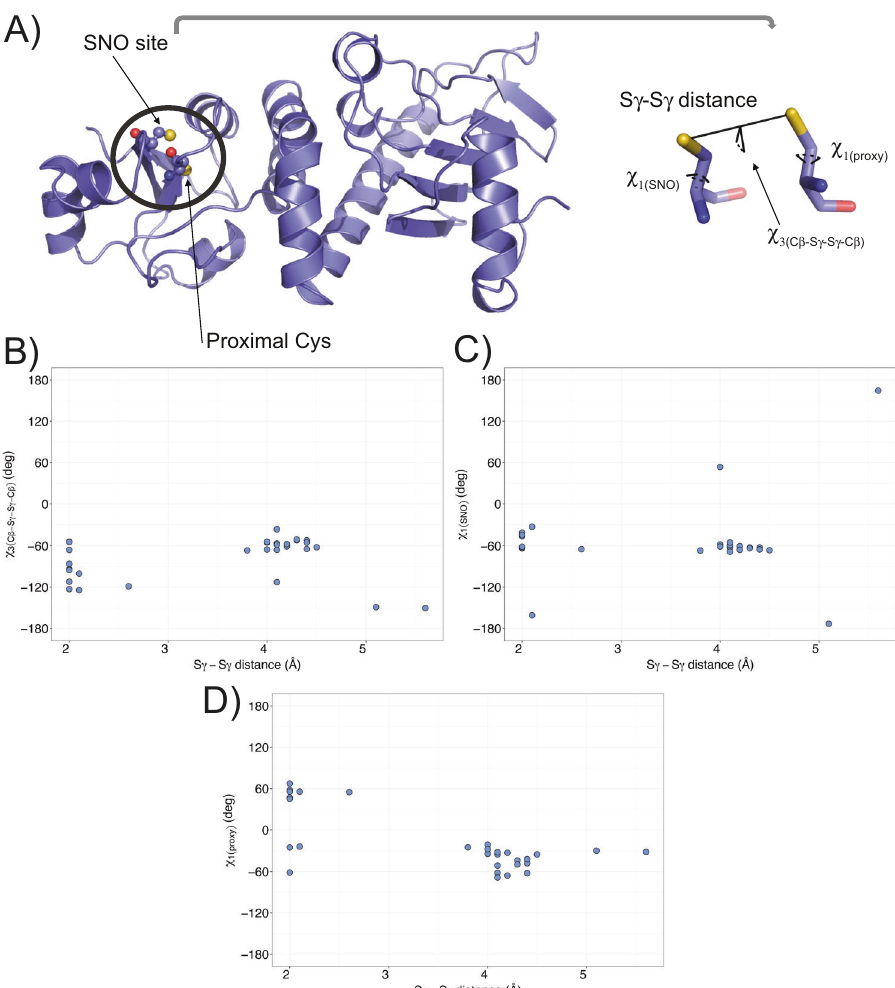
Fig. 1 Conformational heterogeneity of the S- nitrosylated cysteine and its proximal cysteine in the mitochondrial chaperone TRAP1. A In the left panel, the cartoon shows the X-ray structure of the middle domain of Danio rerio TRAP1 (PDB ID entry 4IPE, residues 311 – 567). The spheres indicate the atoms of the S- nitrosylated (SNO) site (C516) and the proximal cysteine (C542). In the right panel, the stick representation shows a conformation of the SNO site and the proximal cysteine. We evaluated the conformational state and orientation of each cysteine, measuring i) the χ 1 dihedral angle of the SNO cysteine ( χ 1(SNO) ), ii) the χ 1 dihedral angle of the proximal cysteine ( χ 1(proxy) ), iii) the distance between the two sulfur atoms of the two cysteines (S γ -S γ distance), and iv) the C β -S γ -S γ -C β dihedral angle. B – D We retrieved from the Protein Data Bank (PDB) the structures available for Homo Sapiens and Danio rerio TRAP1. We evaluated the conformational state of the S -nitrosylated cysteine (C501 and C516, respectively) and its proximal cysteine (C527 and C542, respectively). The scatter plots show the calculated values for each structure of the S γ -S γ distance against ( B ) C β -S γ -S γ -C β , ( C ) χ 1(SNO) , and ( D ) χ 1(proxy) dihedral angles. We observed heterogeneity in the conformation and orientation of the two cysteines, showing S γ -S γ distances in the range of 2 – 5.6 Å and diversity in C β -S γ -S γ -C β (in the